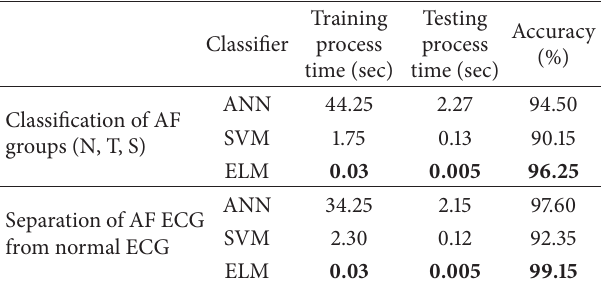
Table 1: The performances of ANN, SVM, and ELM for classifying AF groups and separating AF ECGs from normal